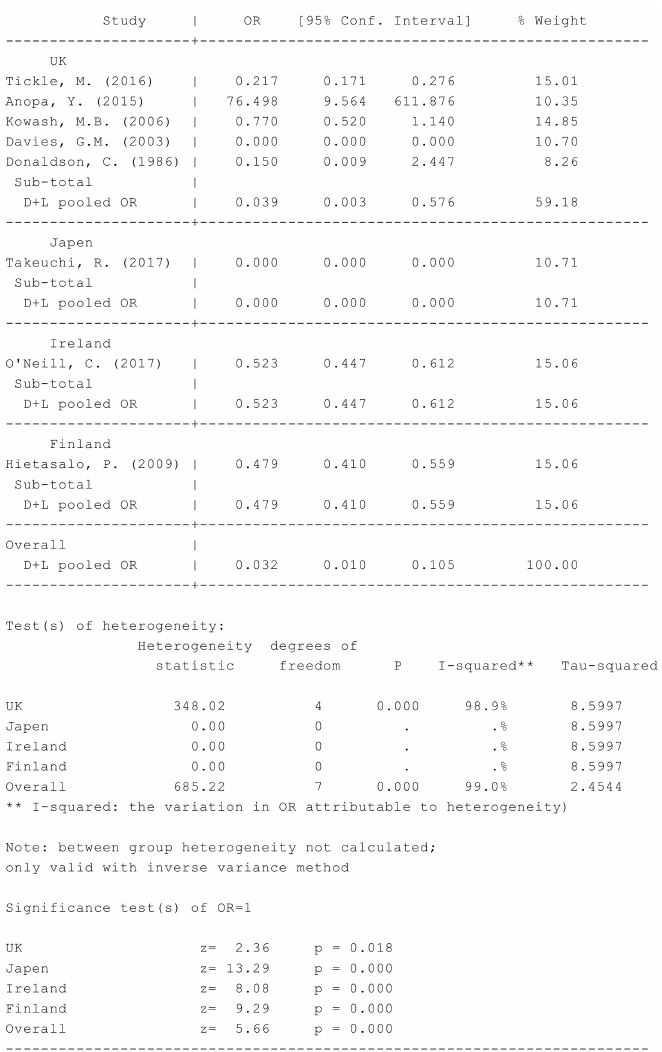
FigureA6. STATAdo-filesforanalysisofFigure7. “metanDMFTinterventionCostintervetion, DMFTcontrol Costcontrol label (namevar = Author, yearvar = year) by (Country) random or”